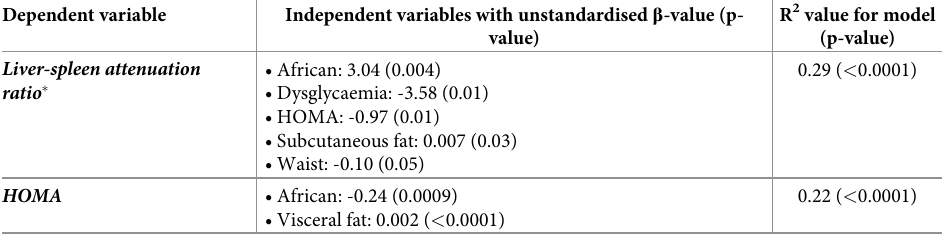
Table 3. Multivariable linear regression models for liver: Spleen attenuation ratio and insulin resistance (HOMA).